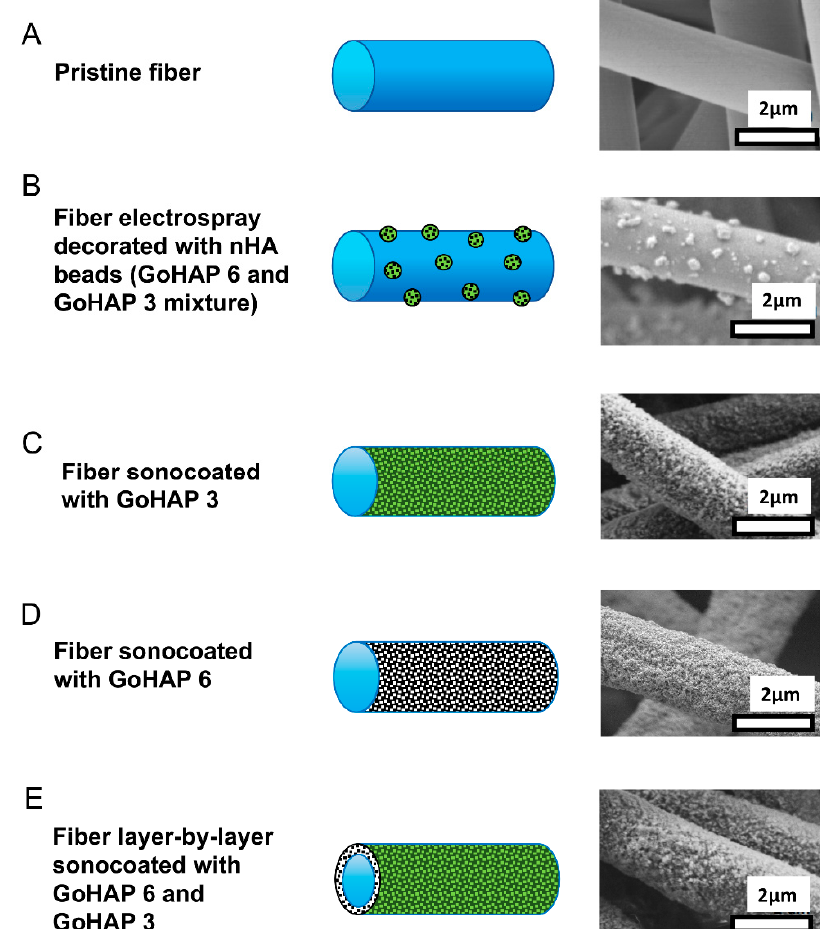
Figure 4. SEM images and morphology scheme of PDLLA / PLGA membrane fibers: ( A ) Pristine PDLLA / PLGA fiber; ( B ) fiber electrospray covered with nHA beads; ( C ) fiber sonocoated with GoHAP 3; ( D ) fiber sonocoated with GoHAP 6; ( E ) fiber layer-by-layer sonocoated with GoHAP 6 and GoHAP 3, respectively.